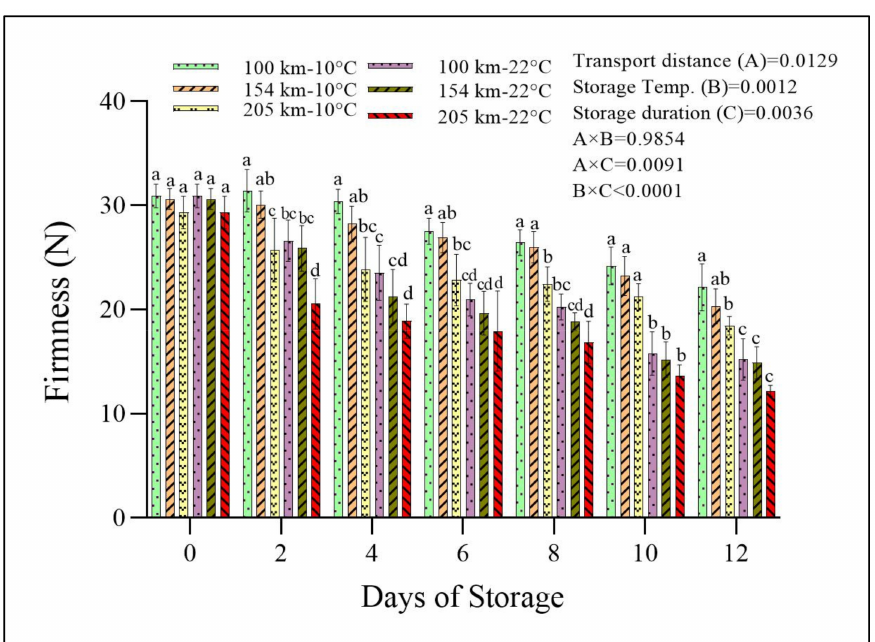
Figure 9. The firmness of tomatoes from three different distances stored at (A) 10 ± 0.5 ◦ C (95 ± 1% RH) and (B) 22 ± 1 ◦ C (65 ± 5% RH) for 12 days. Error bars represent standard error (SE) of the mean values ± S.E. of 10 measurements (readings) of 5 tomato replicates. Bars with different letters (per day) are significantly different ( p < 0.05) performed by the Tukey HSD test and numerical values of A, B, and C are p